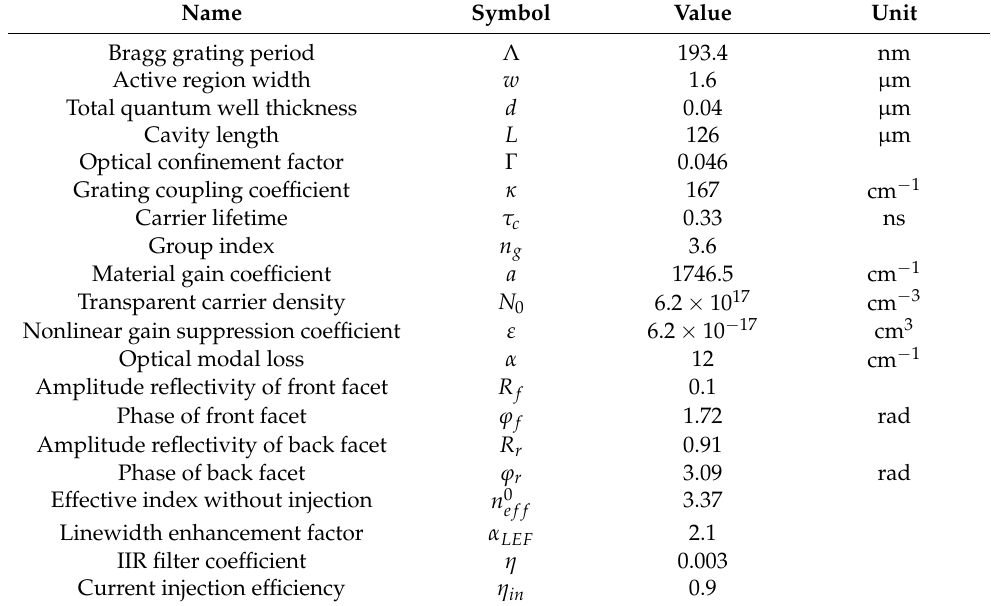
Table 1. Extracted parameters of the DFB